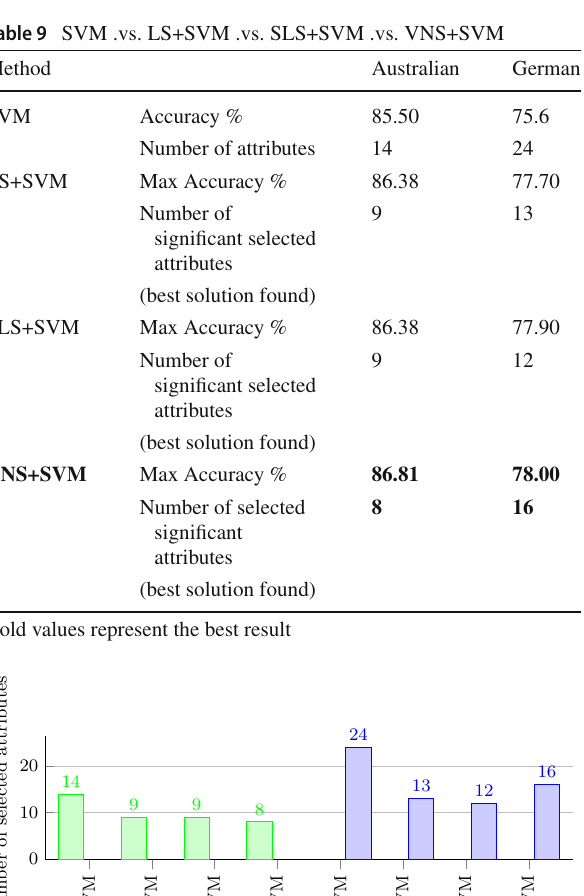
Fig. 4 LS+SVM versus SLS+SVM versus VNS+SVM on Australian dataset